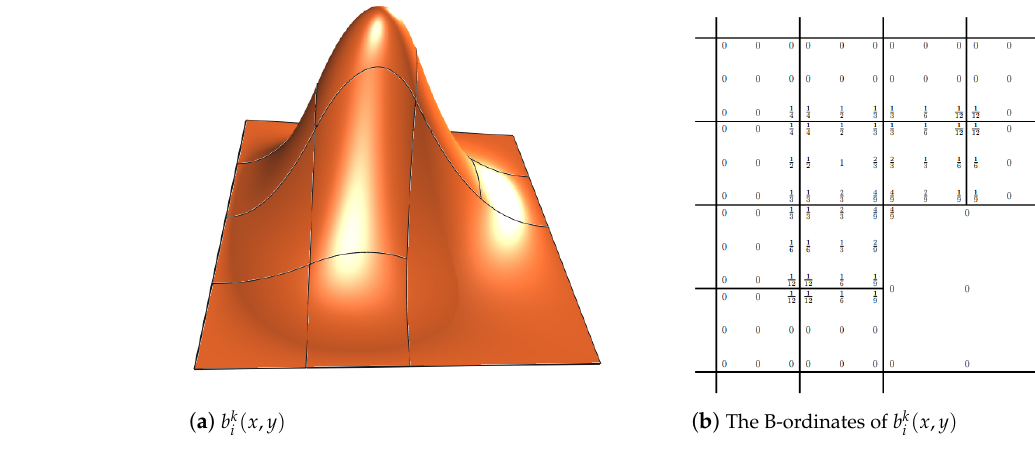
Figure 13. A basis function at level k .